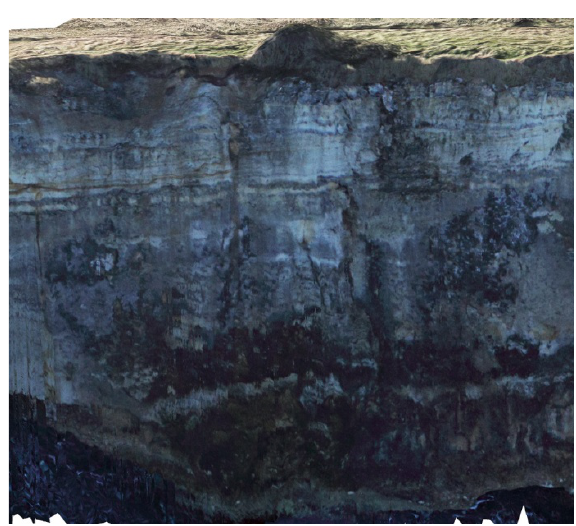
Figure 7. Details of the discontinuity